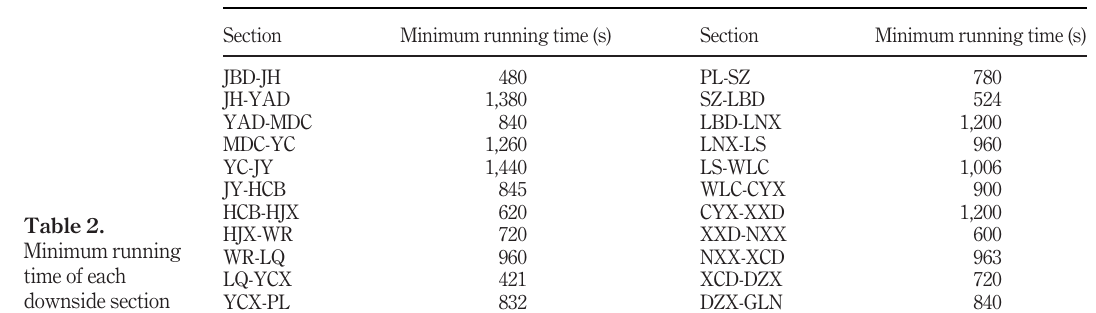
Figure 5. Running time of downside sections